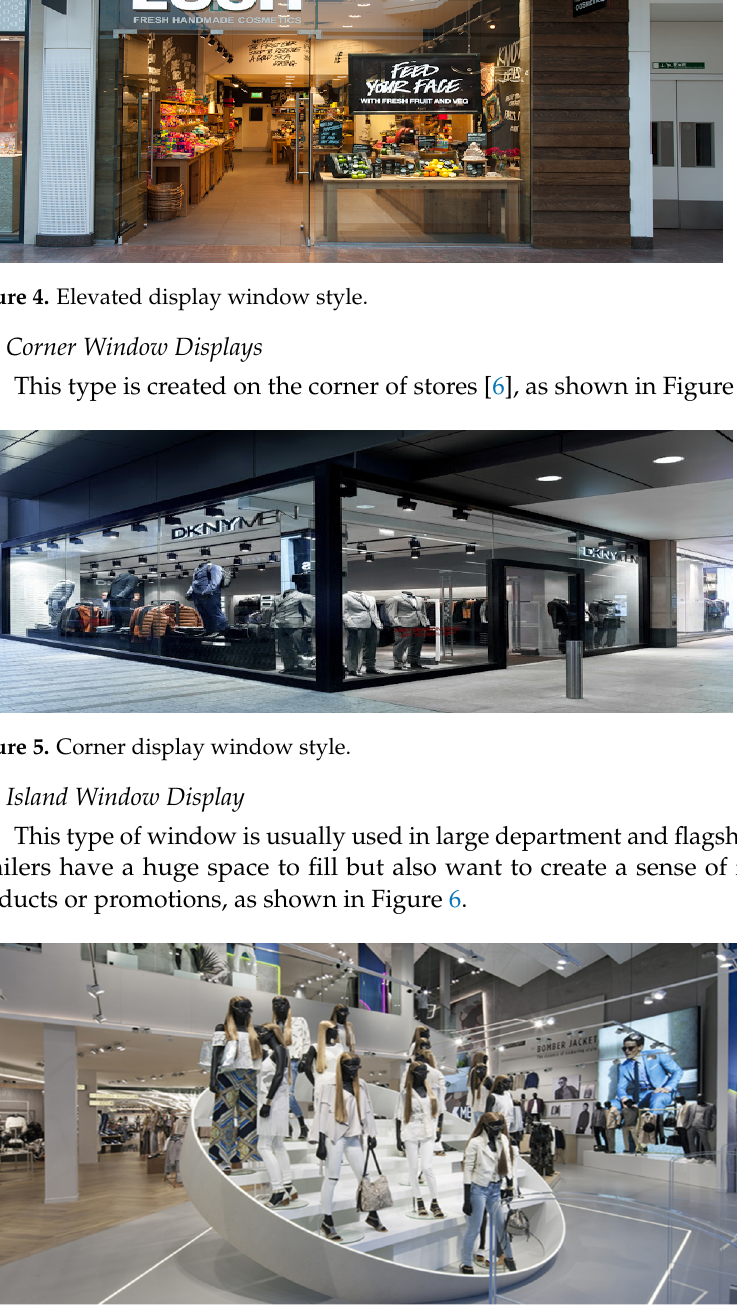
Figure 3. Open display window style.